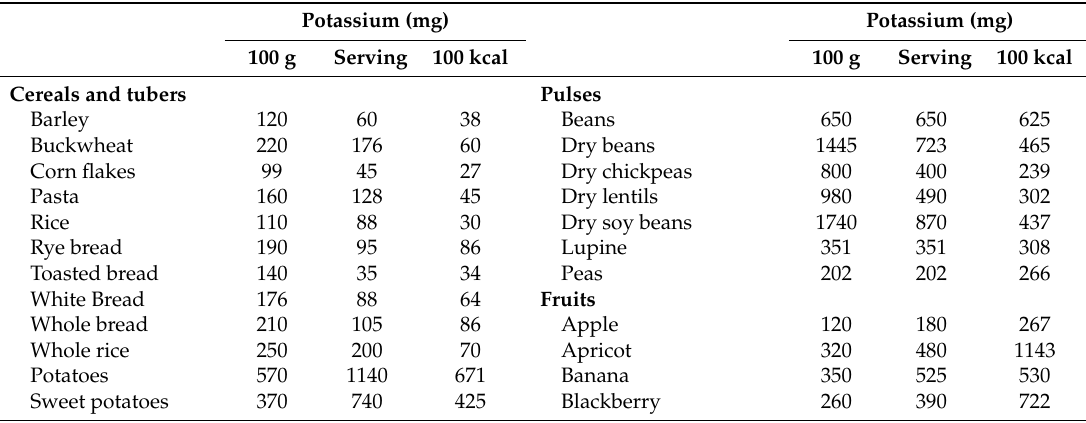
Table 3. Potassium content of plant-based